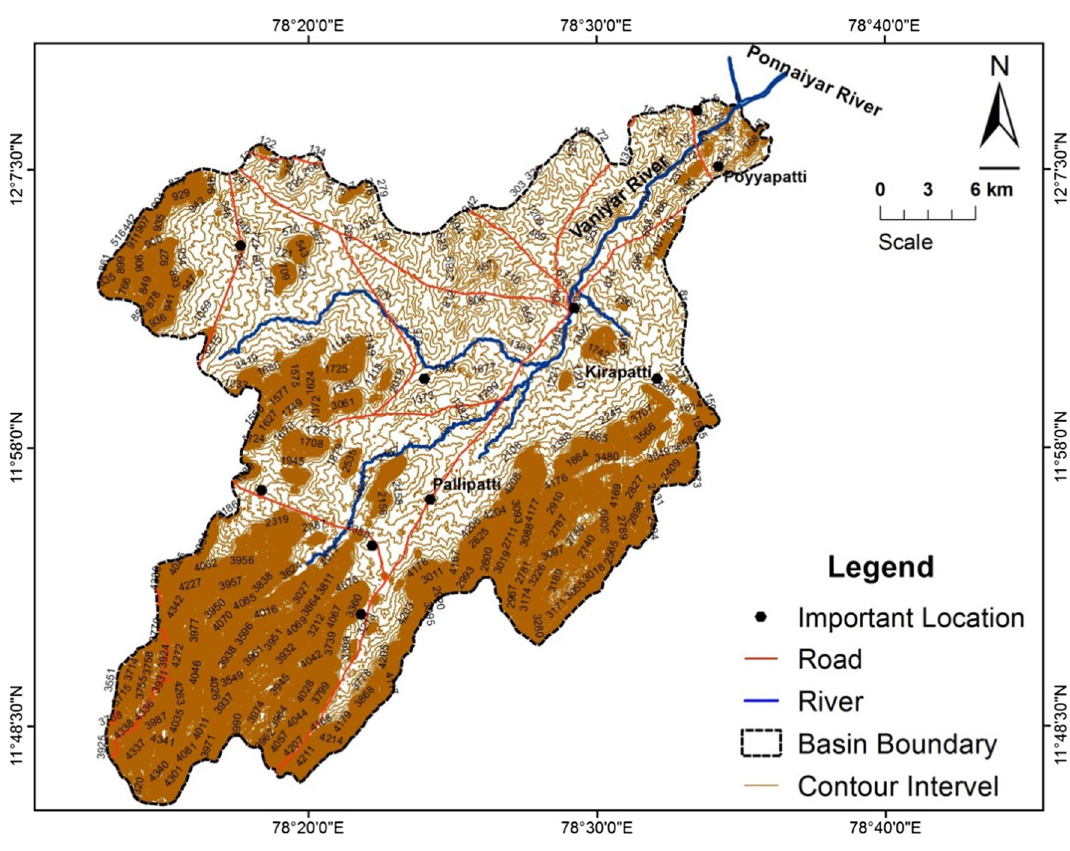
Fig. 9 Topographic map of the Vaniyar sub basin ( Source : SRTM)